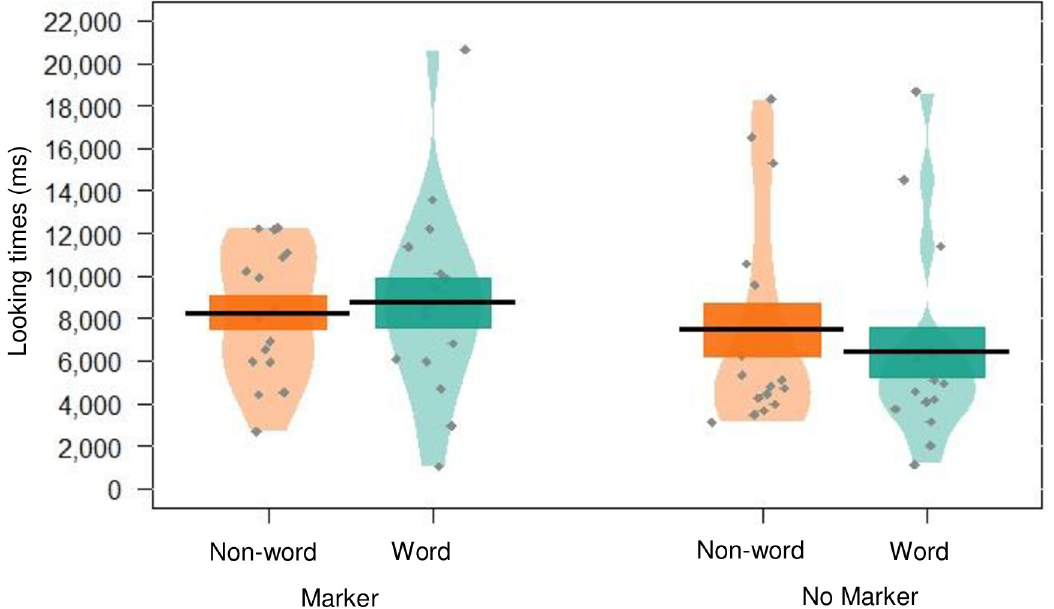
Fig 1. Pirate plot depicting the (raw) mean looking times to words and non-words, given for each condition. Black lines indicate the mean, and coloured blocks indicate SE . The distribution of looking times is illustrated for each group, with individual data points in